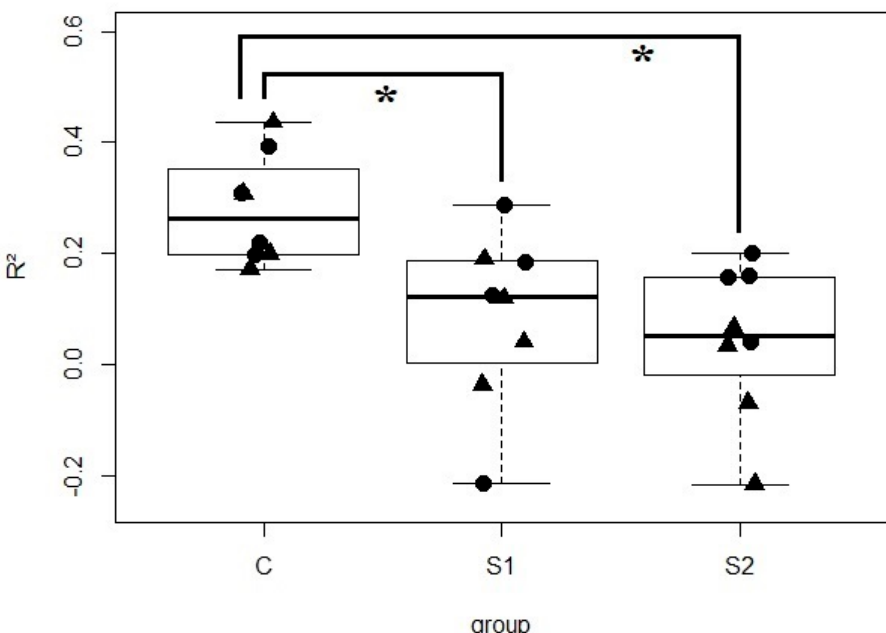
Figure 2. R 2 values of the neutral model fitting the S1, S2 and control piglets. Circles are the 14-day-old piglets and triangles are the piglets at 4 weeks (weaning). Star (*) indicate that the R 2 values are significantly different (at the 5% threshold of the ANOVA) between the control piglets and the piglets force-fed with the S1 or S2 microbial suspensions prepared from the donor sows with low ARG levels, illustrating that the inoculation modified the assembly rules of the microbes.